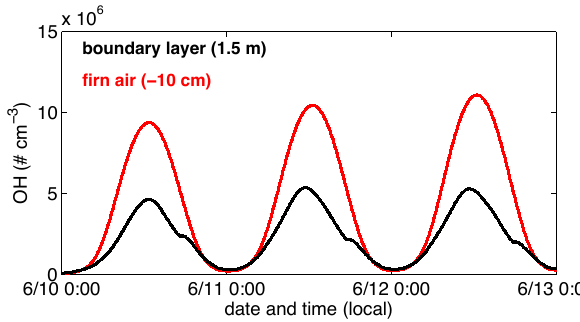
Fig. 14. OH concentrations predicted in the atmosphere and inter- stitial air for the base case. The model predicts a significantly en- hanced oxidizing environment in the interstitial